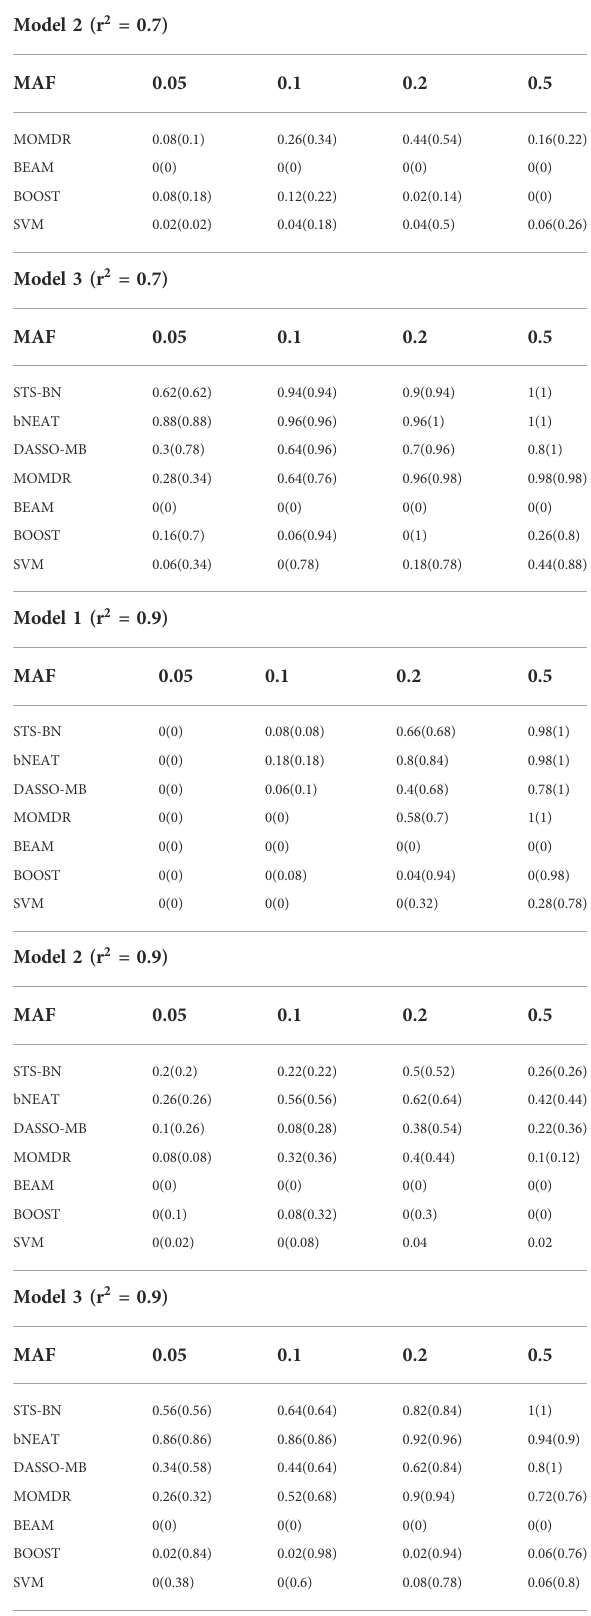
TABLE 4 ( Continued ) Performance Comparison. Powers of simulations are given by this table. The percentage of the simulated datasets in which the correct markers are detected and at most two false positives are included is shown in the